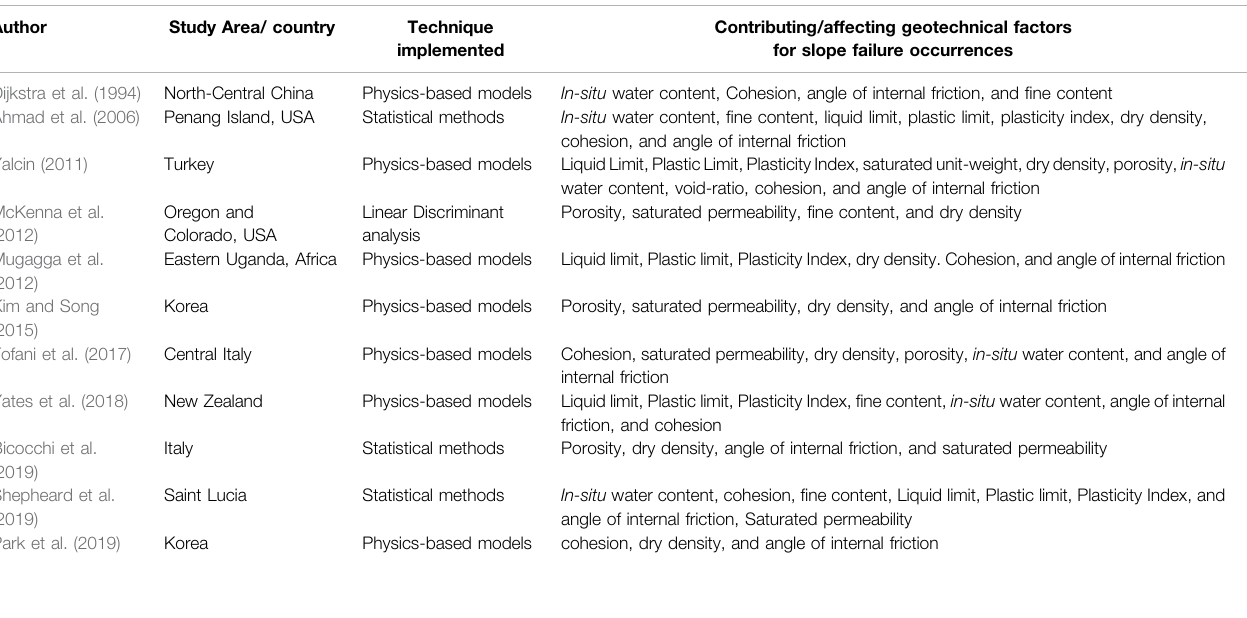
TABLE 1 | Contributing geotechnical factors reported in the